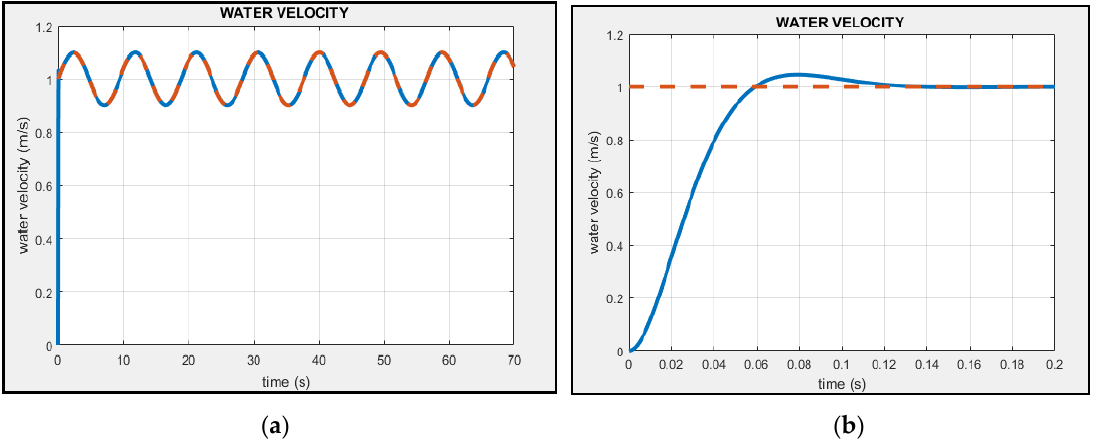
Figure 7. The results of the algorithm. The red line is the input velocity of the water and the blue line is the velocity of the water calculated with the algorithm. ( a ) The results for 70 s. In the first seconds, the sensor measures a little late; it can be seen in ( b ) that the settling time is 0.15 s. Then, as seen in (a), the sensor calculates the velocity correctly.